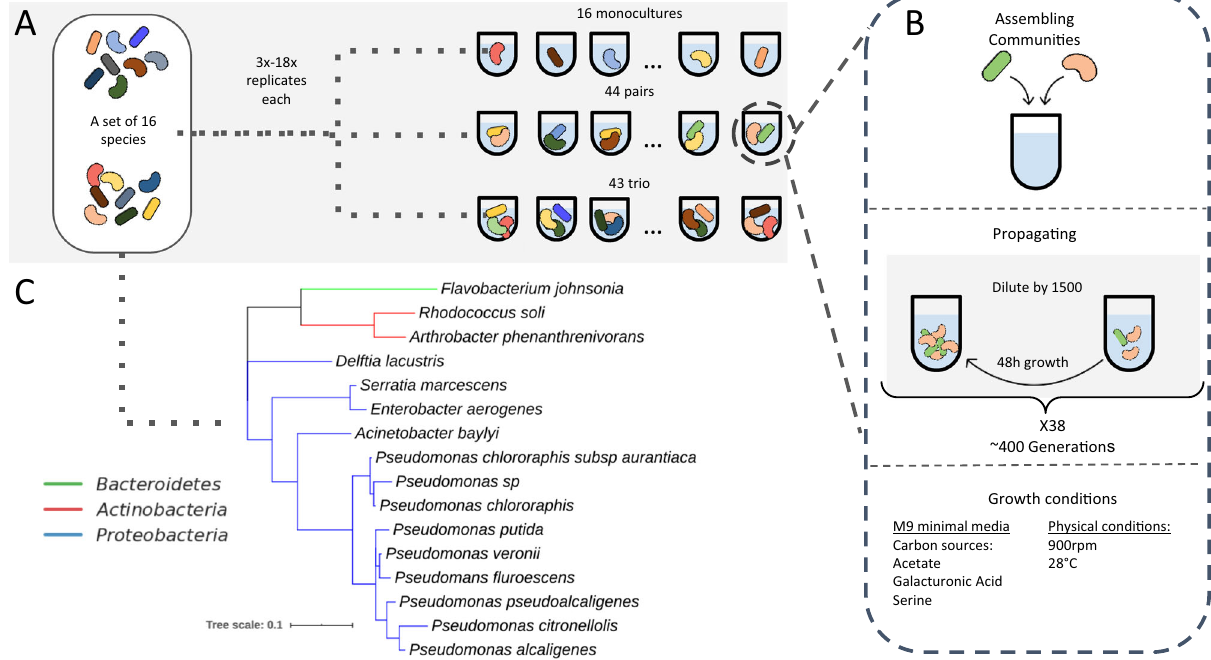
Fig. 1 A high-throughput evolutionary experiment involving 87 communities composed of subsets of a 16 species set. A Subsets of the 16 species were used to assemble 44 pairs and 43 trios. All 16 species were evolved in monocultures in parallel to the assembled communities. Each community was grown in 3 – 18 replicates, a full list of communities and the number of replicates is found in Supplementary Table 2. B Each community was grown in M9 minimal media supplemented with three carbon sources in cycles of 48 h growth-dilution by a factor of 1500. Overall, communities grew for 38 cycles, which correspond to ~400 generations. C Phylogenetic tree based on the full-length 16S sequence of the 16 species used for this